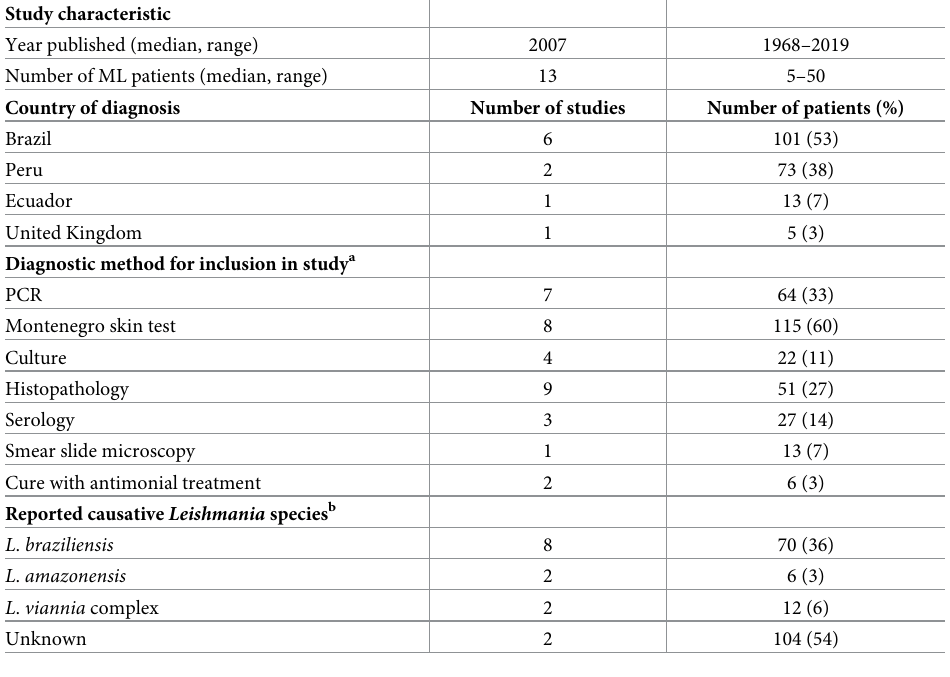
Table 3. Characteristics of the 10 case series reporting on 192 ML patients included in the systematic review.